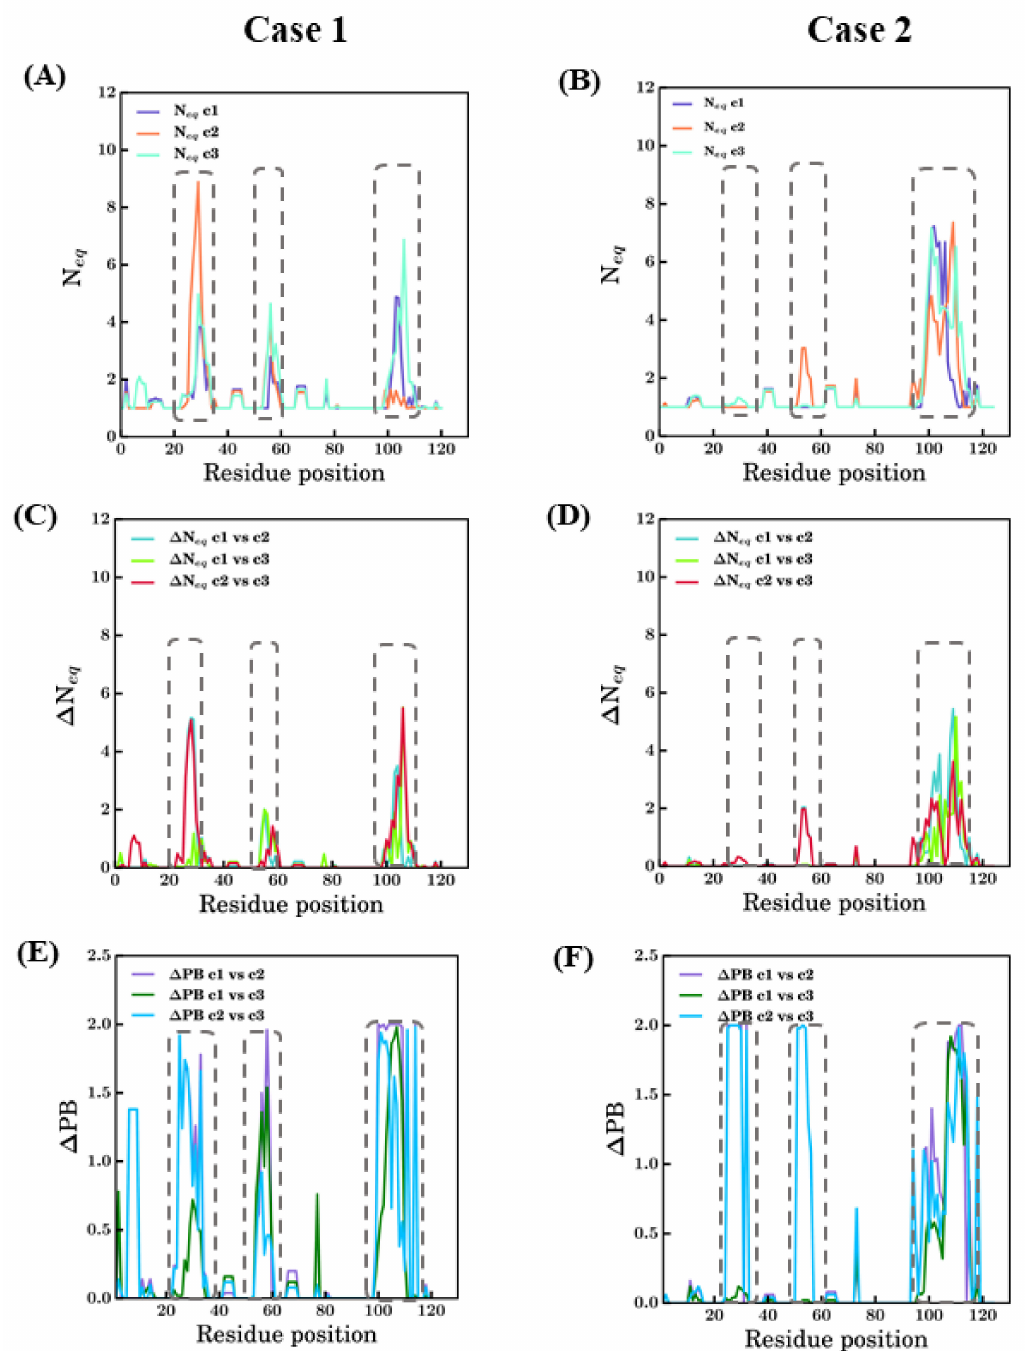
Figure 8. Summary of changes in conformational sampling. Two modeling case studies of PDB ID 4MQS:B (Case 1) and PDB ID 5E7B:A (Case 2) are presented. ( A , B ) PB entropy ( N eq ) [22] (raw values can be found in Supplementary Files S1 and S2); ( C , D ) change in PB entropy ( ∆ N eq ) [44] and ( E , F ) differential PB signature at each position ( ∆ PB) in different scenarios [44,45]. Each graph has all the three scenarios represented in different colors and notations c1, c2, and c3 for scenarios bestSeqIdTemp , bestStructTemp, and 3bestSeqIdTemp . The dotted rectangles approximately denote the regions CDR1, CDR2, and CDR3 indicated from left to right in each